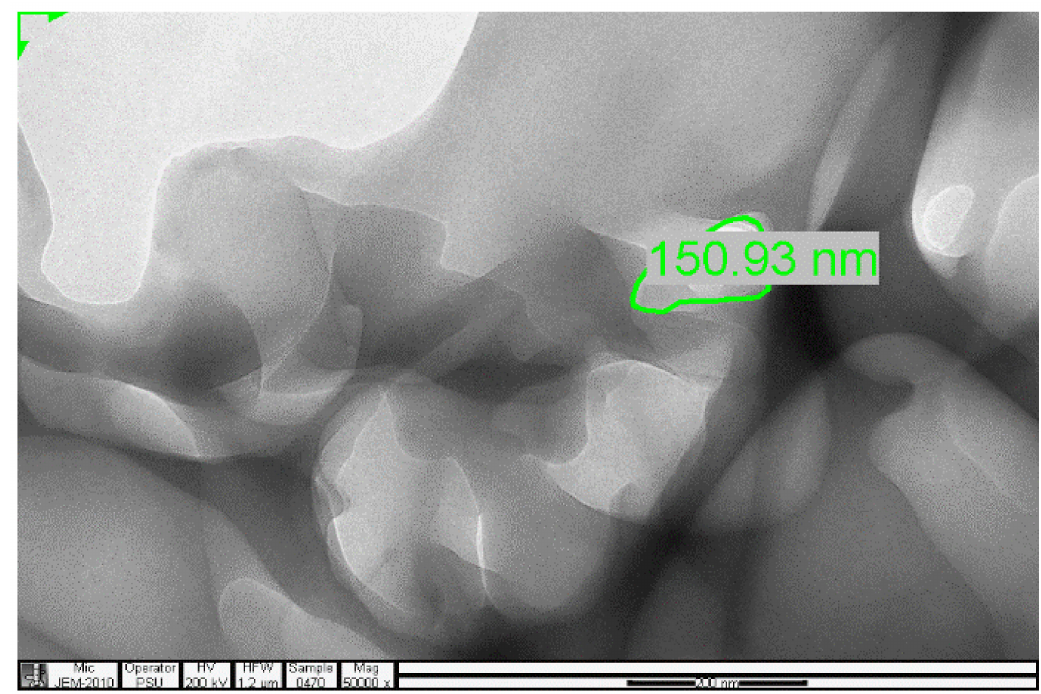
Figure 15. TEM micrograph of the 3-Phenylpiridine MIP.